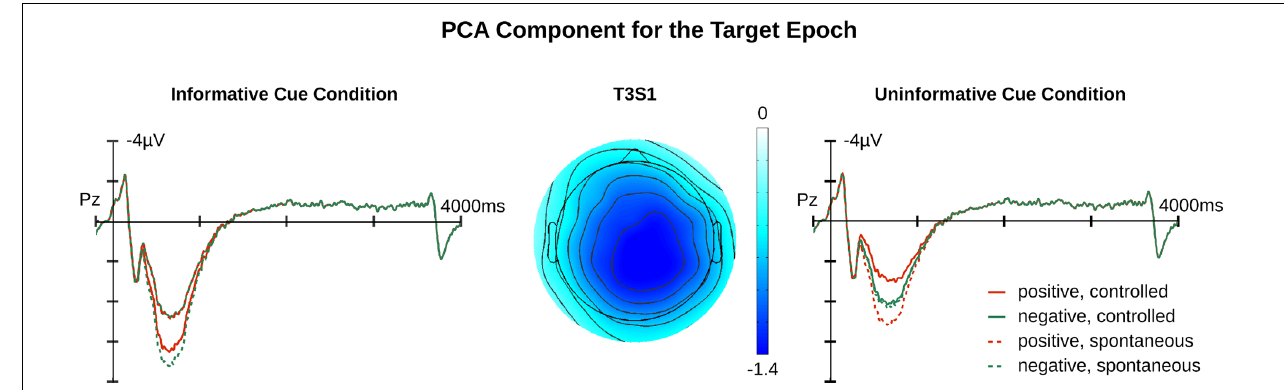
FIGURE 5 | Relevant PCA component for target epochs. Illustrated are component traces and topography for T3S1target, the only LPP like component identified for targets. The waveforms are the projection traces at Pz for the informative and uninformative cue conditions. T3S1target peaked at 833 ms after target onset. Additional time course information is available in the Supplementary